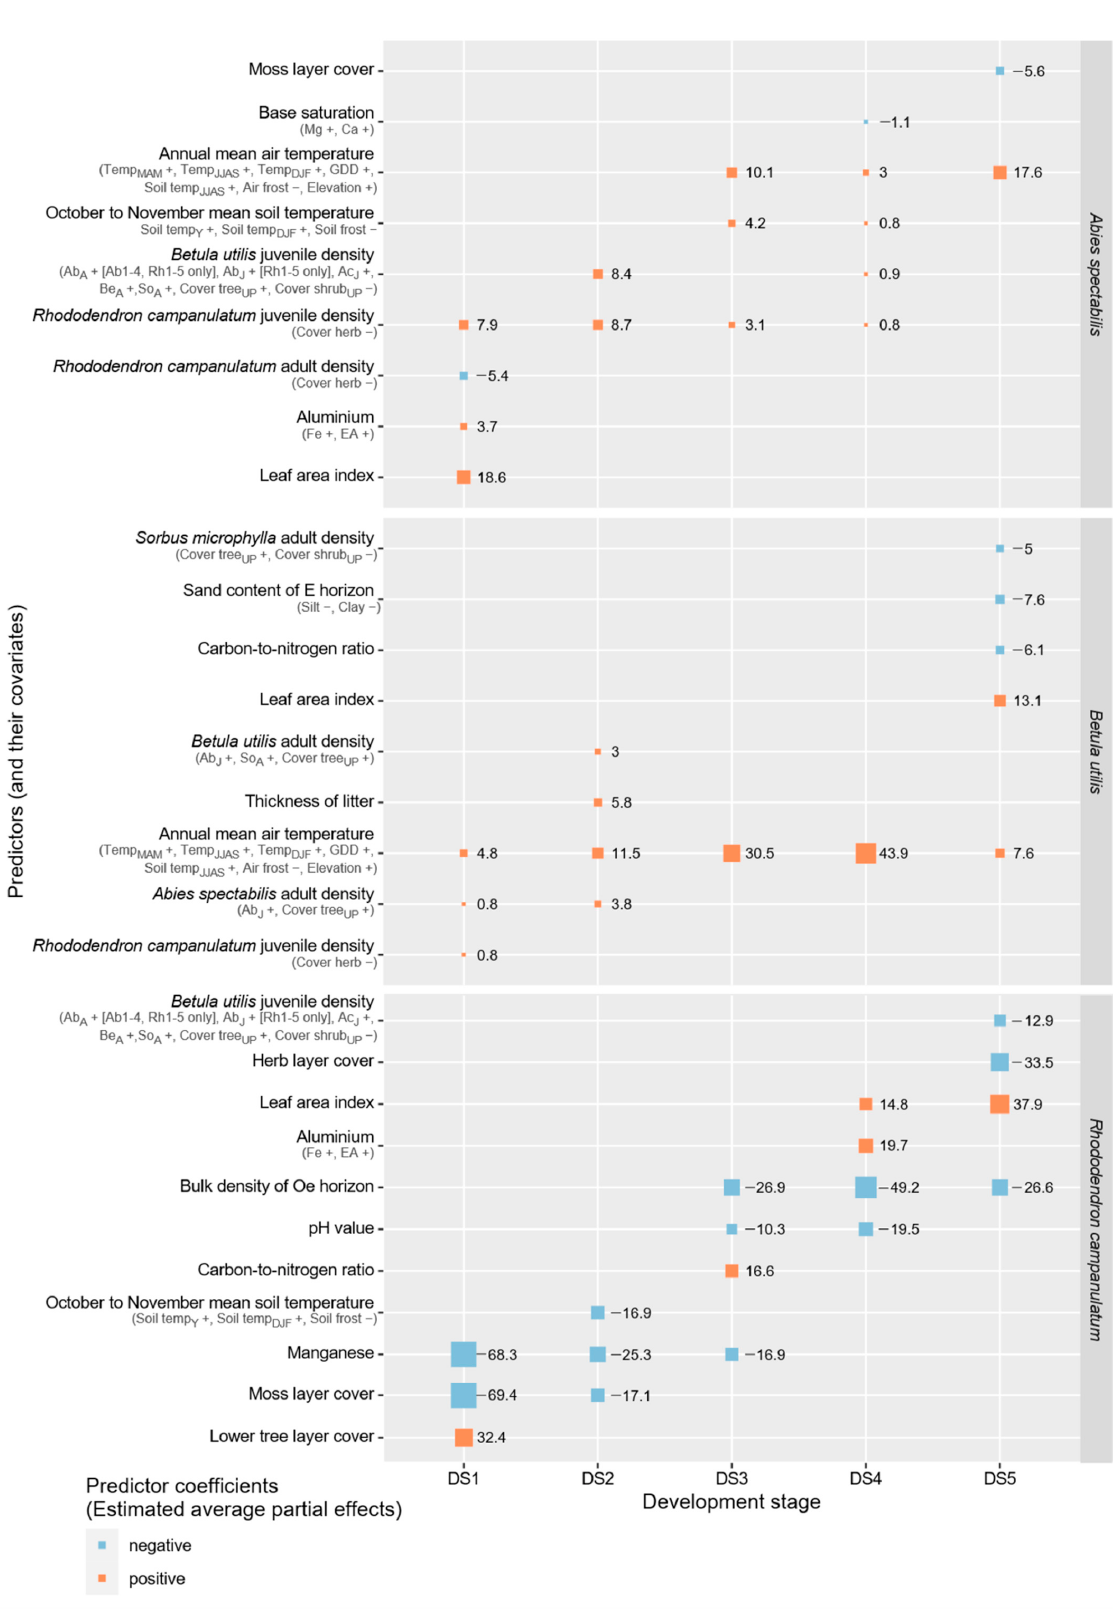
Figure 3. Predictors of the 15 development stage- and species-specific models and their estimated partial effects. Order of predictors highlights their shifting through development stages. Square size corresponds to the magnitude of partial effects. It indicates the predictors’ contribution on